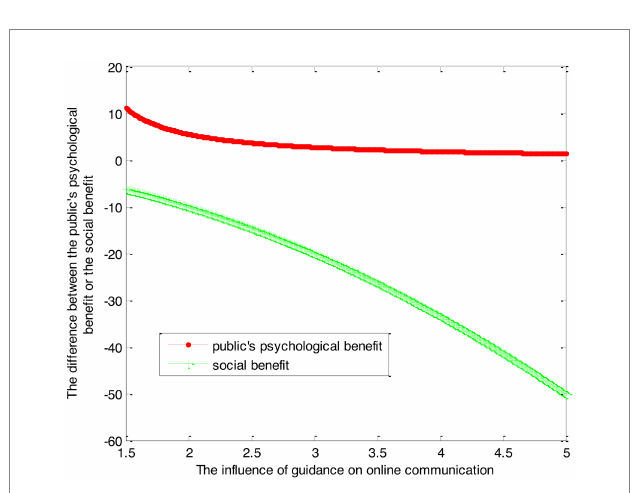
FIGURE 4 The difference between government guidance and social force guidance.